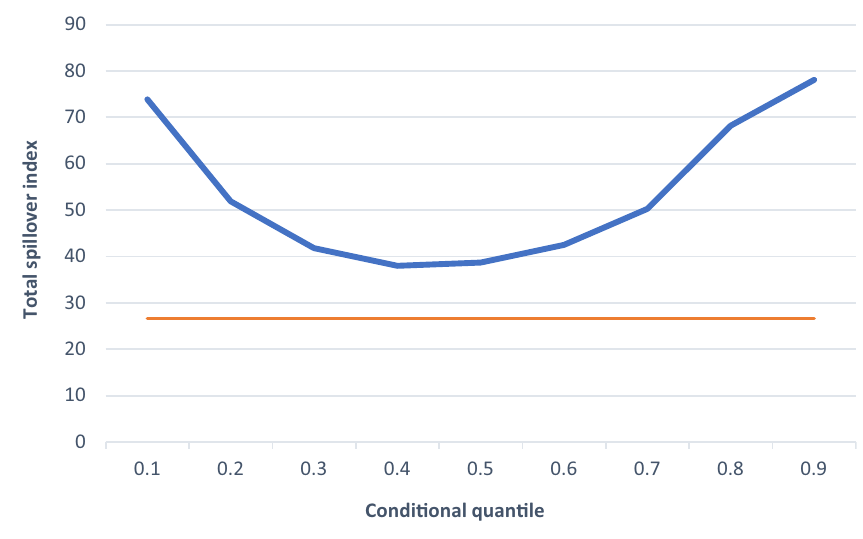
Fig. 2 Total Spillover Index (TSI) along the conditional distribution. The horizontal line is the TSI estimated at the conditional